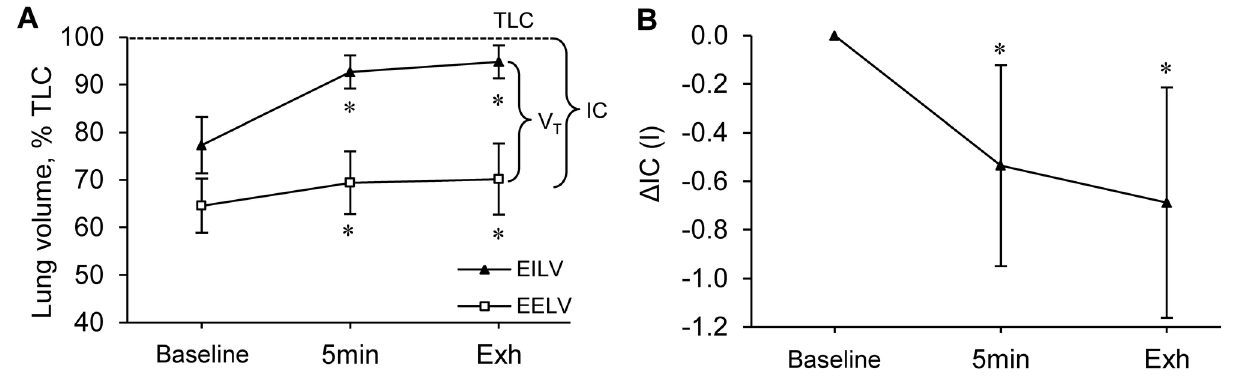
Figure 1. End-expiratory (EELV) and end-inspiratory (EILV) lung volumes as a percentage of total lung capacity (TLC), tidal volume (V ) and inspiratory capacity (IC) before (Baseline), 5 minutes after the start of constant-load cycling (5 min) T and at exhaustion (Exh) (Panel A). Changes in IC during the same conditions (Panel B). *, significant differences from Baseline (P<0.05). doi: